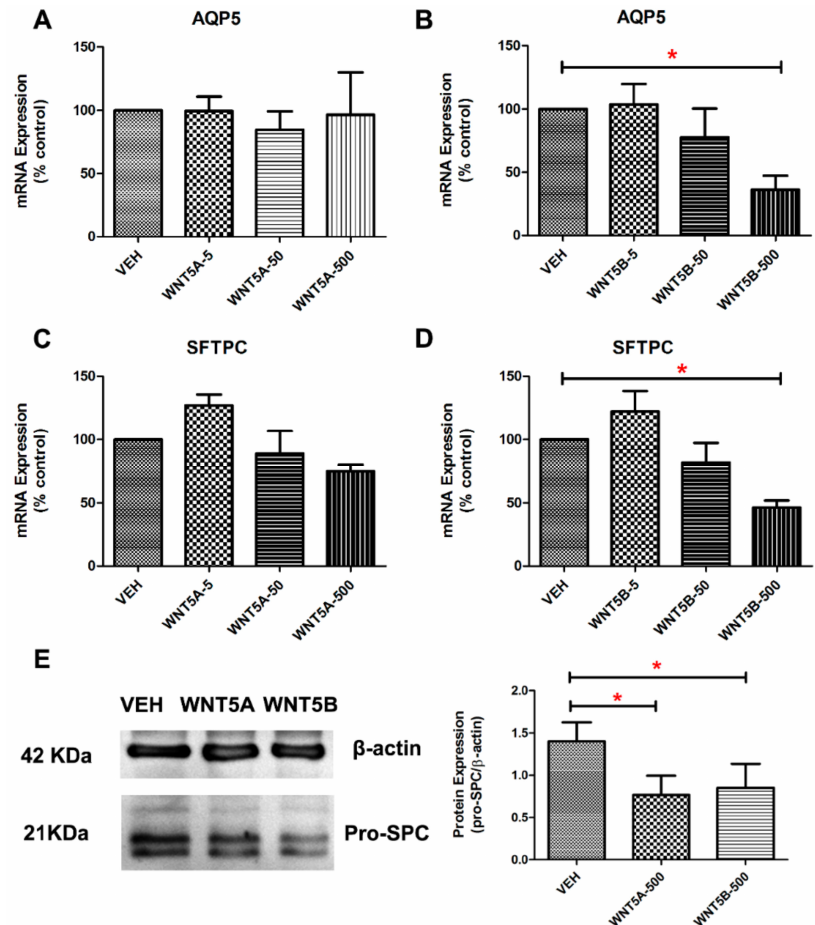
Figure 2. WNT-5A and WNT-5B decreased the expression of alveolar epithelial cell markers in precision-cut-lung slices (PCLS). ( A – B ) Normalized mRNA expression level of Aquaporin 5 (AQP5) in PCLS treated with di ff erent concentrations of recombinant WNT-5A or WNT-5B (0-, 5-, 50-, 500 ng / mL). ( C – D ) Normalized mRNA expression level of surfactant protein C (SFTPC) in PCLS treated with di ff erent concentrations of recombinant WNT-5A or WNT-5B (0-, 5-, 50-, 500 ng / mL). ( E ) Representative Western blot of the protein level of pro-surfactant protein C in PCLS treated by recombinant WNT-5A (500 ng / mL) and WNT-5B (500 ng / mL). Bands were quantified by densitometry in 3 separate experiments. Data are expressed as mean ± SEM, * p <